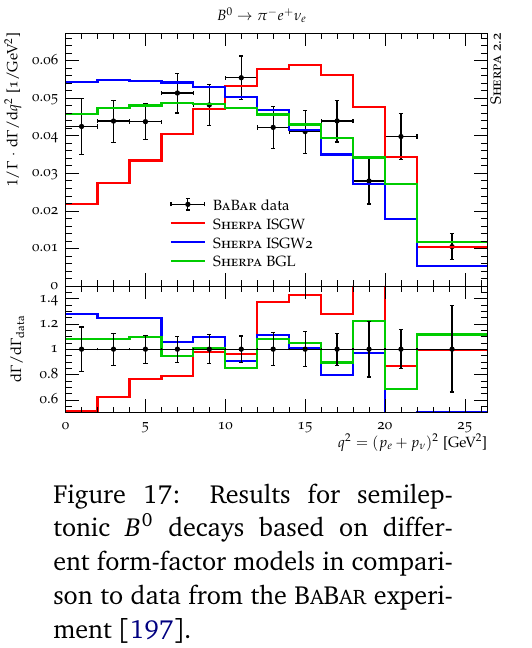
Figure 18: Different predictions for the decay-plane angle between hadronically decaying τ -leptons from Higgs-boson